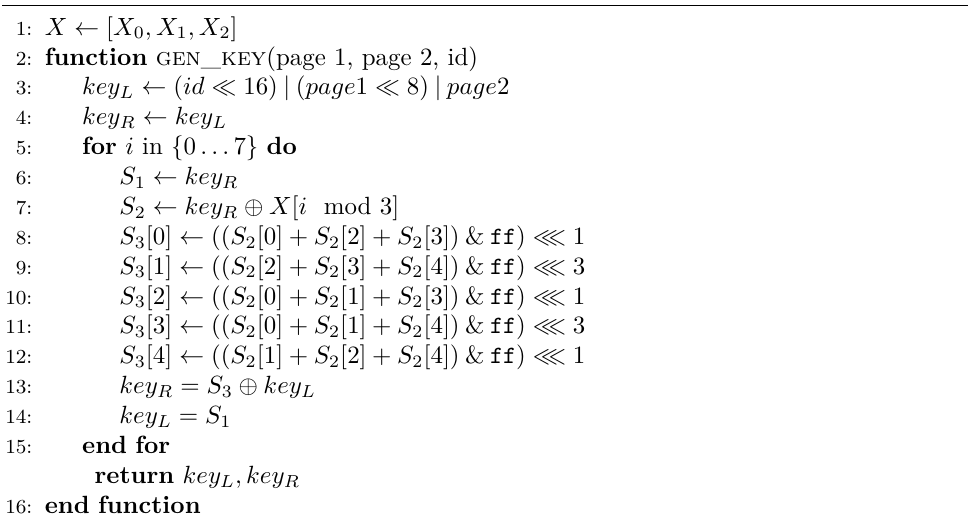
Algorithm 4 The Toyota key generation algorithm reverse engineered from immobiliser firmware. The three 5-byte constants X 0 . . . X 2 have been redacted on the manufacturers